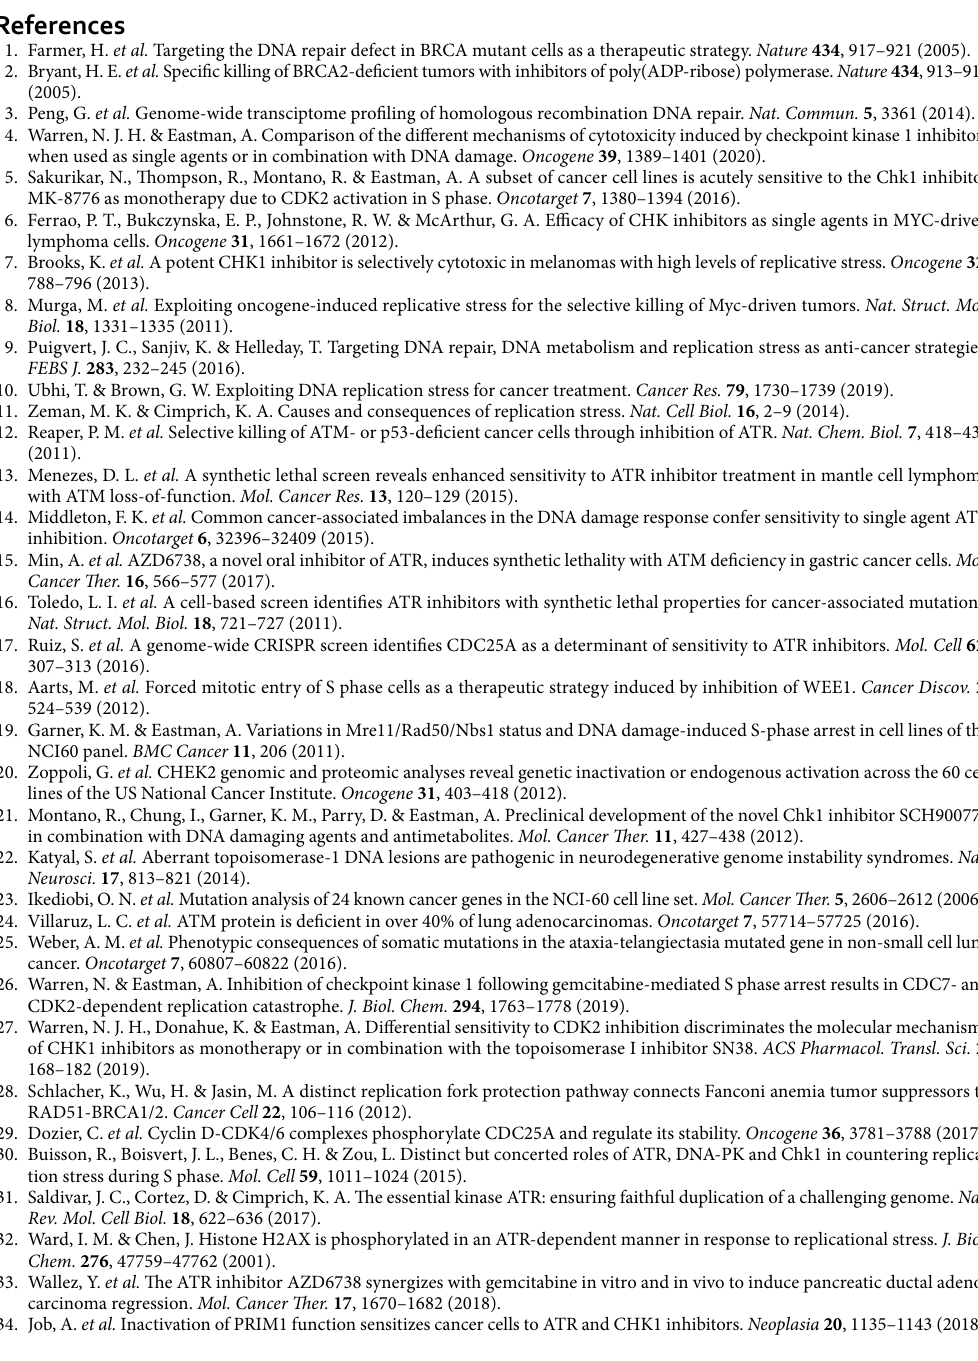
Figure 7. Dependence of γH2AX and sensitivity to ATRi on CDK2 and cyclin A. ( A ) AsPC-1 cells were incubated with 1 µM AZD6738 for 6 h, concurrent with 0–10 µM CVT313. Cells were harvested and analyzed by flow cytometry. This experiment was repeated in 4 additional cell lines as shown in Supplementary Fig. 5A. ( B ) AsPC-1 cells were plated at 10,000 cells/well, then with 0–10 µM AZD6738 concurrent with 0–10 µM CVT313 for 48 h. The drugs were removed and cells harvested every 2 days. Curves that descend below the starting inoculum reflect cell death. ( C ) AsPC-1 cells were transfected with siRNA targeting cyclin A, cyclin E or a control siRNA, then incubated with 3 µM AZD6738 for 24 h. Cell lysates were analyzed by western blotting. * = non-specific band. ( D ) MDA-MB-231 cells were incubated with 10 ng/mL SN38 for 24 h, the drug was removed, and further incubated with 0.6 µM AZD6738 concurrent with 0–80 µM CVT313. After an additional 6 h, cells were harvested, fixed and analyzed by flow cytometry. This experiment was repeated in PC3 cells as shown in Supplementary Fig.